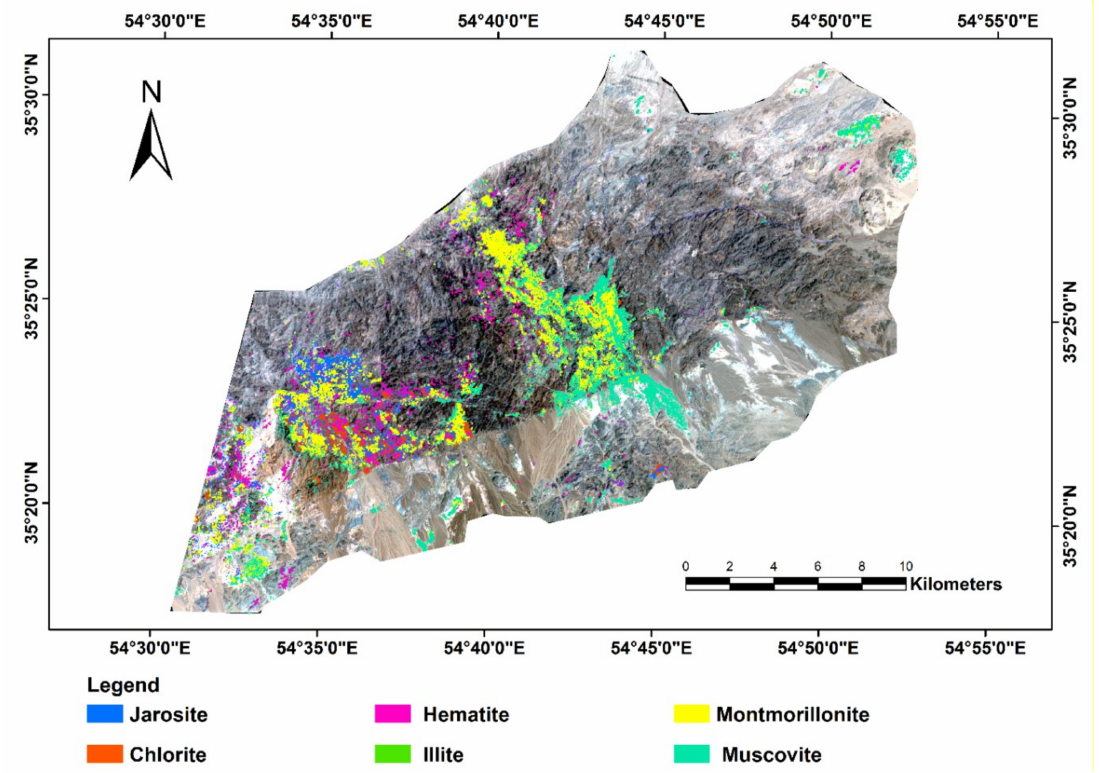
Figure 9. Spectral Angle Mapper (SAM) classification map for the study